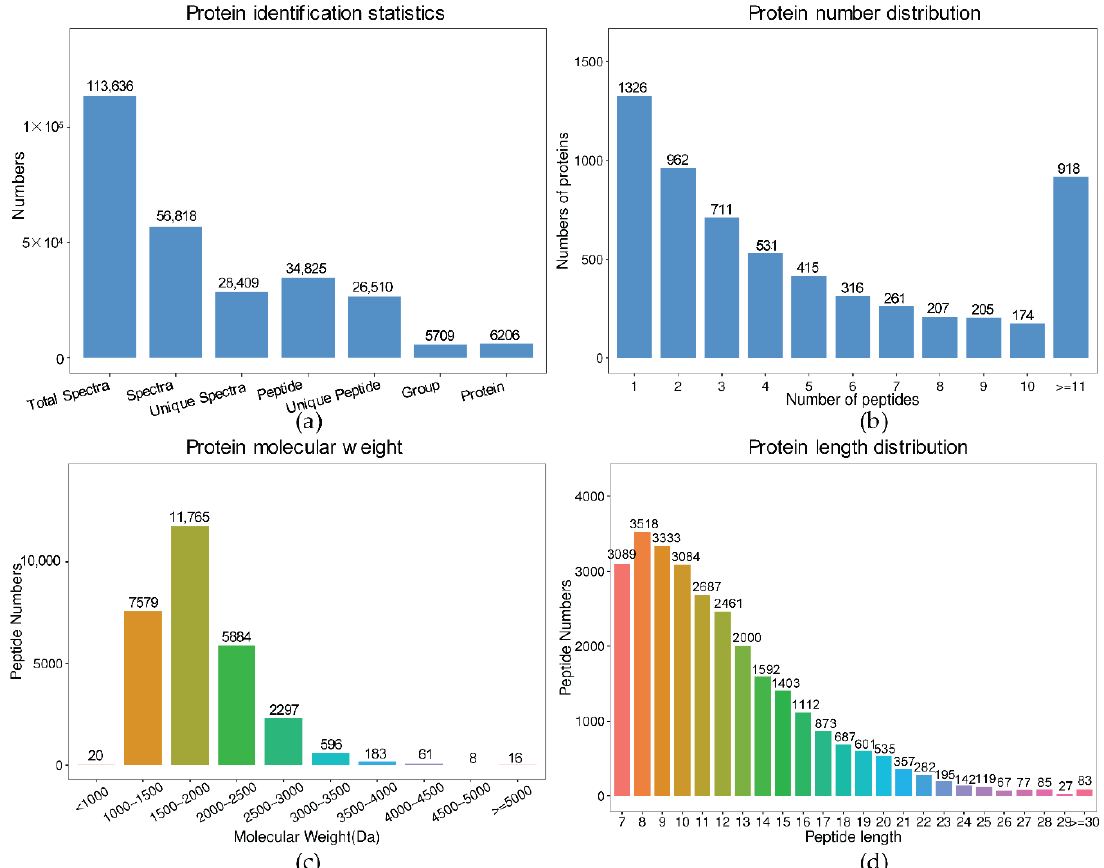
Figure 2. ( a ) The identification results of proteins in P. volubilis seeds; ( b ) Number distribution of all identified unique proteins. The abscissa is the number of peptides, and the ordinate is the number of proteins in this peptide number; ( c ) Molecular weight (Da) of all identified proteins; ( d ) Length distribution of all identified protein.